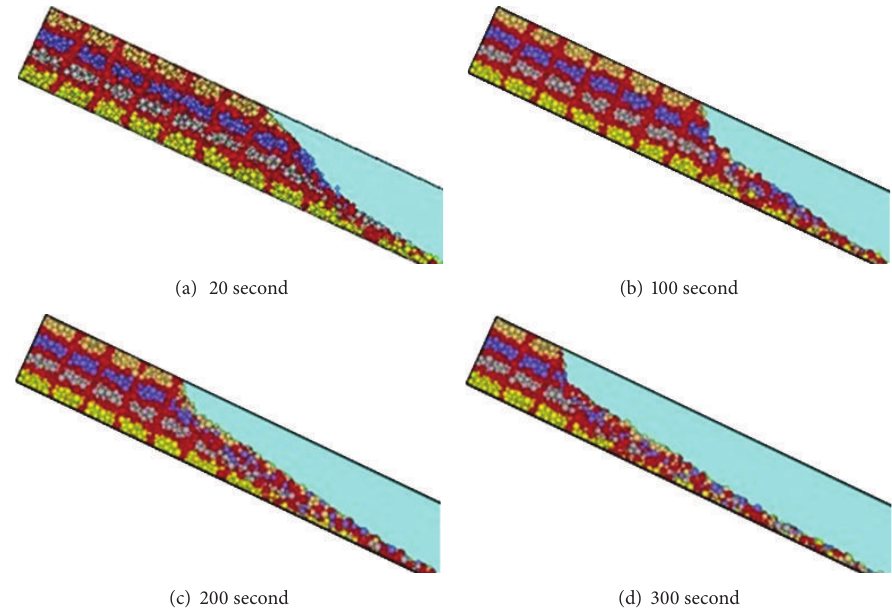
Figure 10: The formation process of debris flows of numerical